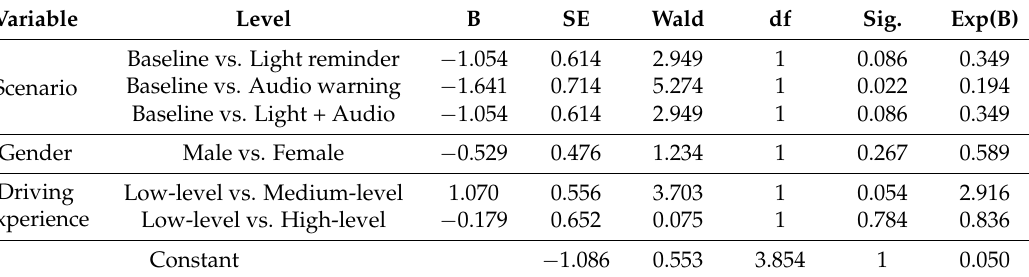
Table 3. Parameter estimates of logistic regression models for the speeding